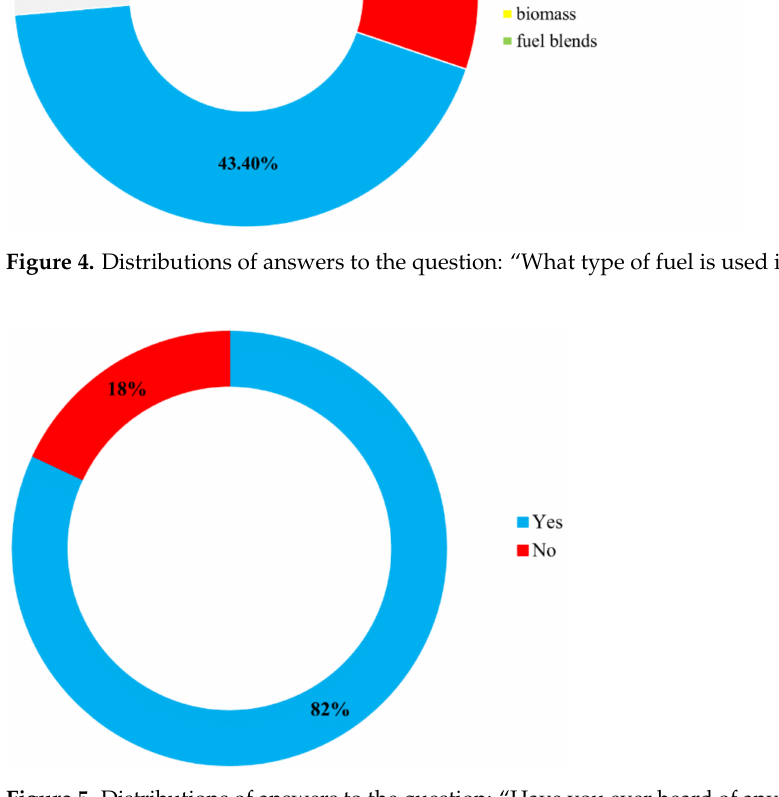
Figure 5. Distributions of answers to the question: “Have you ever heard of any combustion catalysts which improve energy efficiency or reduce the emissions of harmful substances and